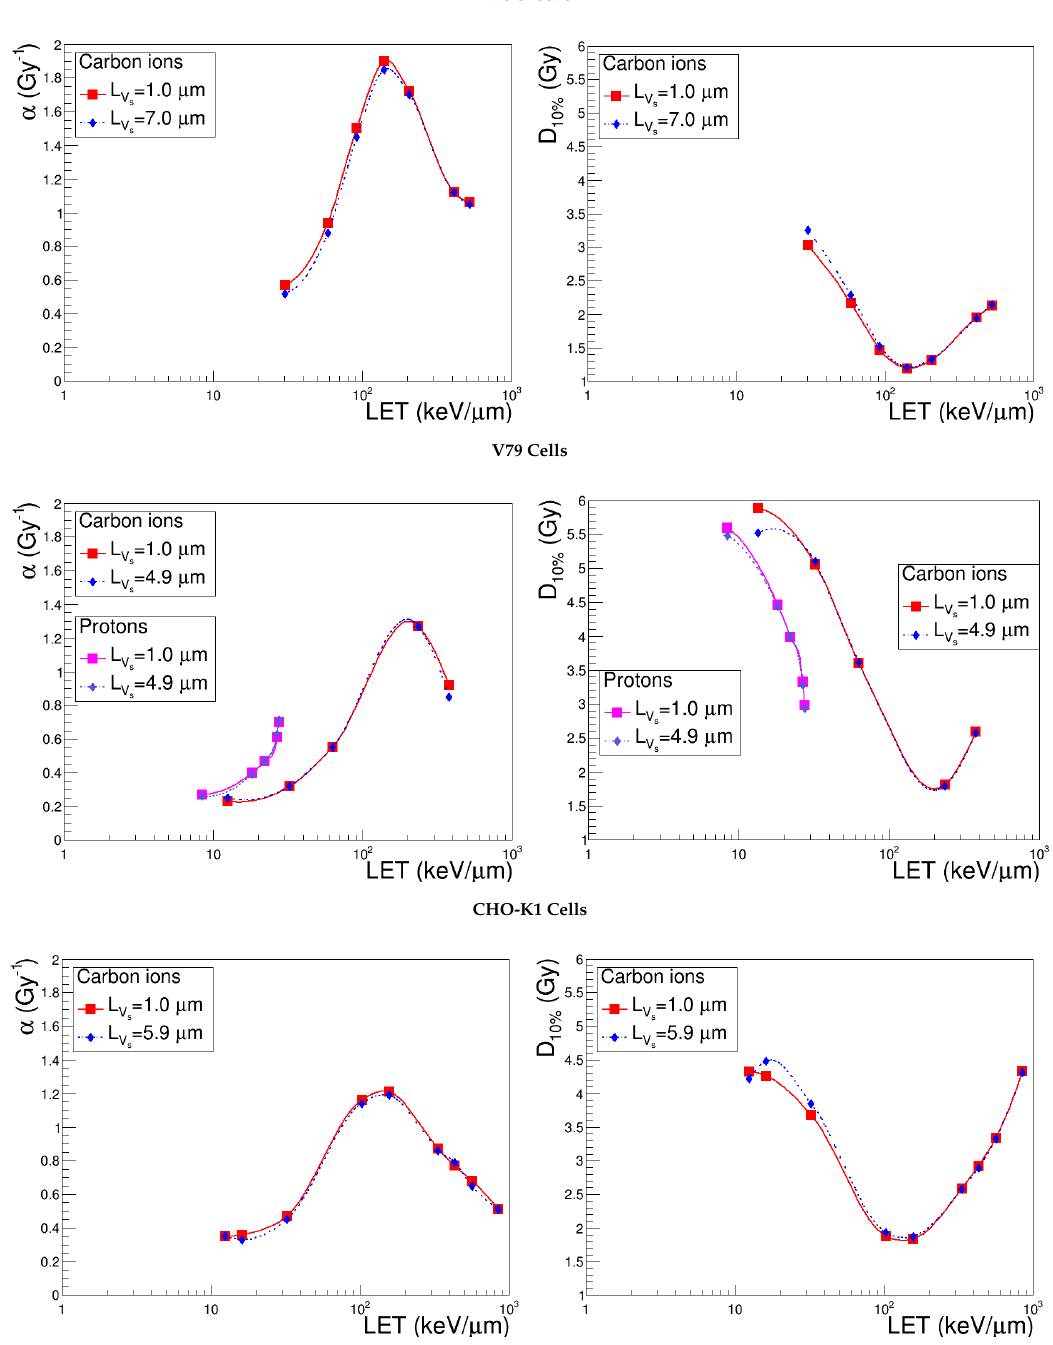
Figure 4. α and D 10% predicted by NanOx for the standard configuration (red curve) and for the varied sensitive volume length (blue curve) keeping the standard radius, as detailed in Table 2. The full symbols correspond to the LET values for which the estimates were performed, while the lines are drawn just to guide the eye and do not represent a